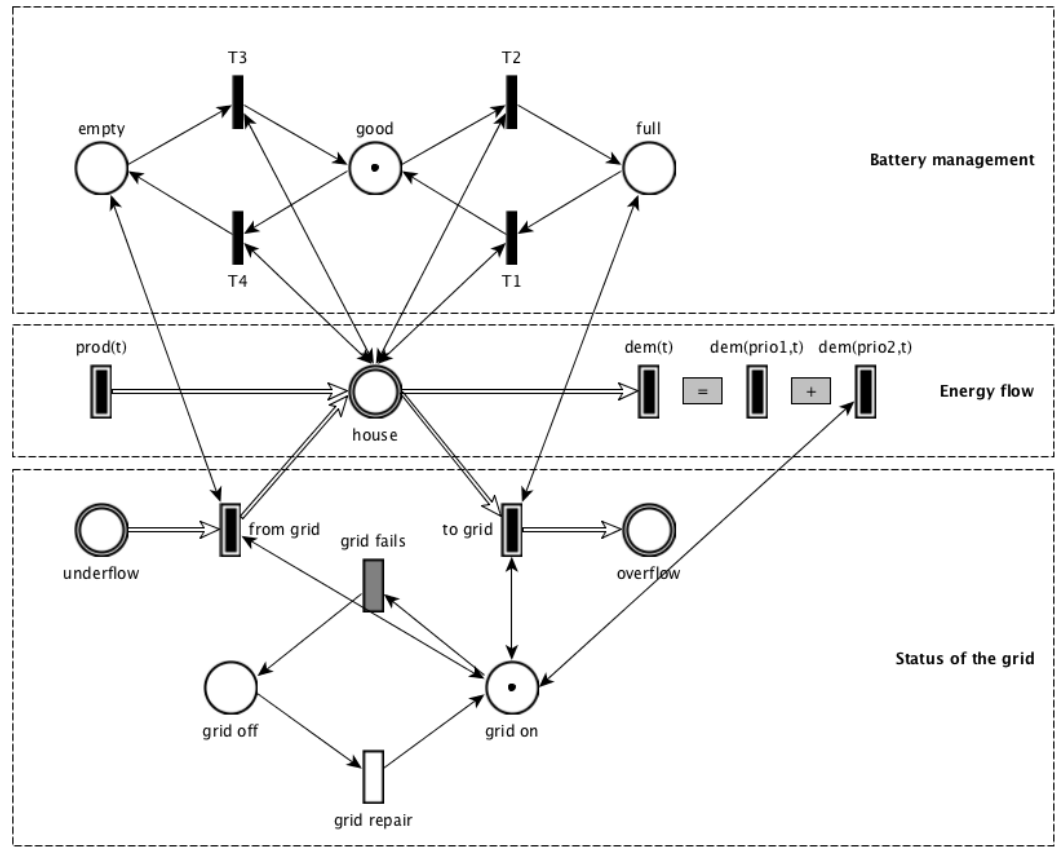
Figure 3. Hybrid Petri net (HPN) model for a domestic smart energy